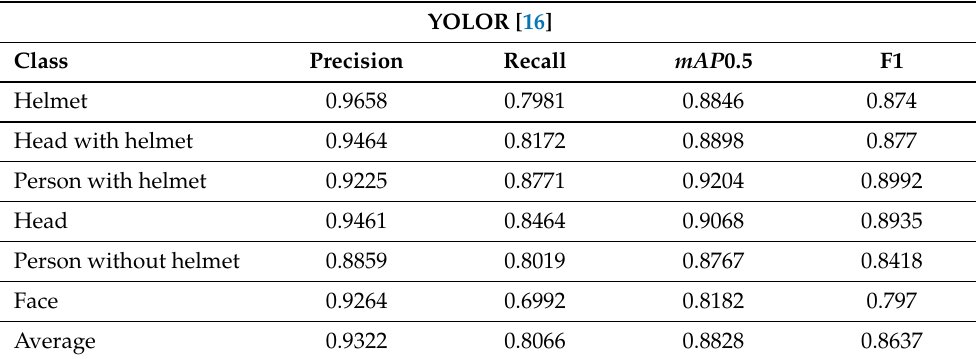
Table 6. The result of the YOLOR [16] model on the SHEL5K dataset.